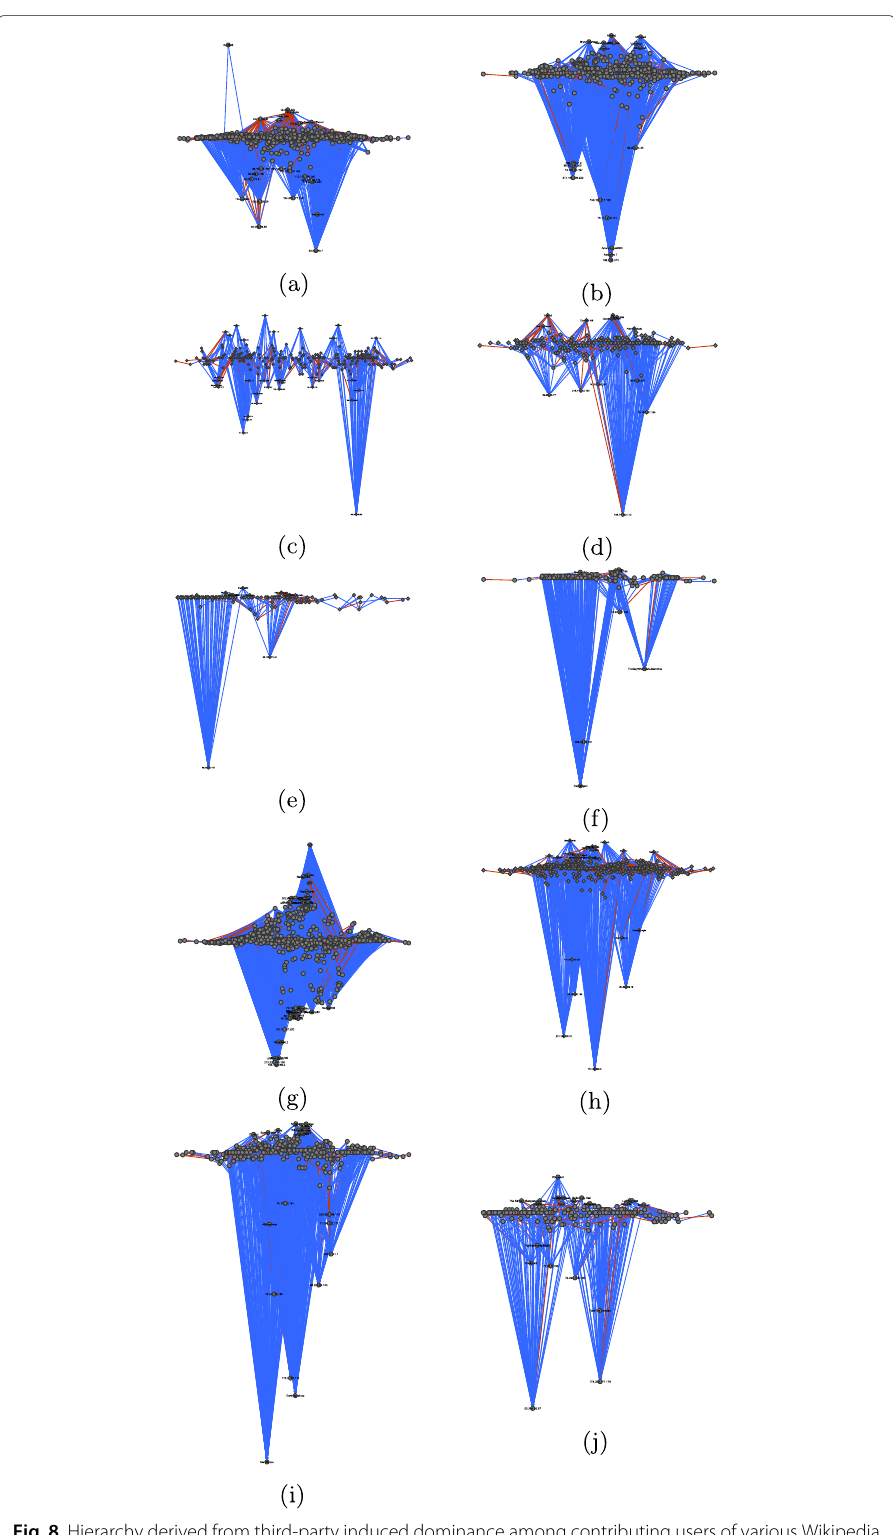
Fig. 8 Hierarchy derived from third-party induced dominance among contributing users of various Wikipedia articles. The y -coordinate of node A is proportional to the value hierarchy . tpe ( A ) . Dominance edges pointing in the wrong direction (i.e., from lower to higher) are coloredred . a Balika Vadhu. b Ganymede (moon). c Greed. d Jay Park. e List of Hollyoaks locations. f Mothra. g Pea. h Shiv Sena. i Swimsuit. j The Third